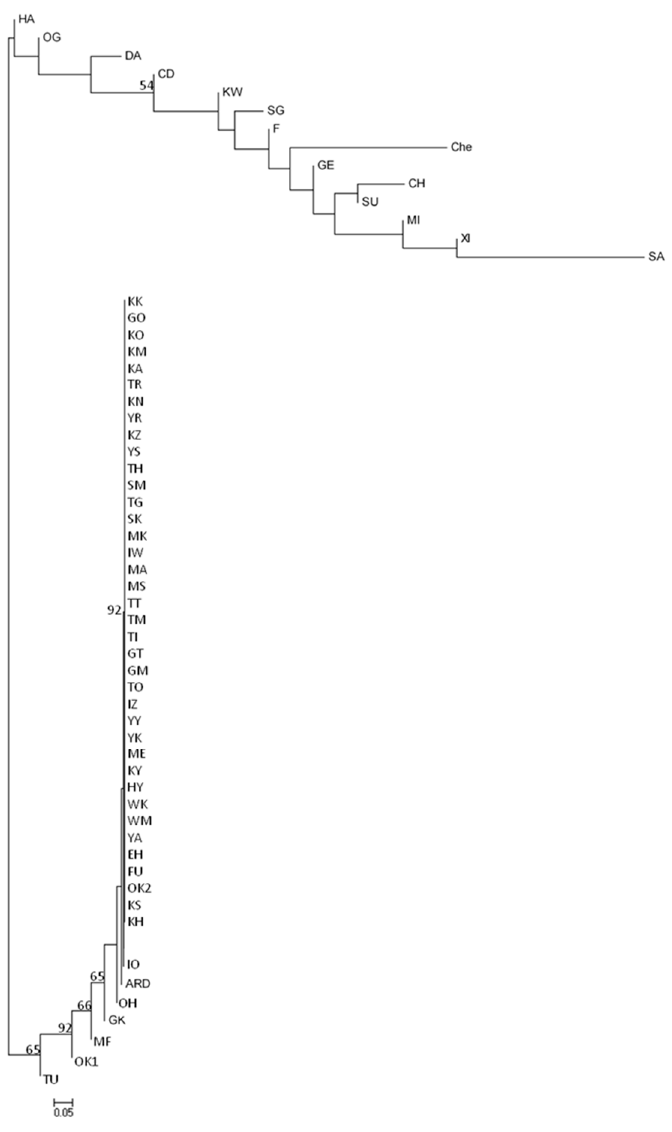
Figure A1. Neighbour-joining tree for Quercus acutissima Carruth. populations based on ( δμ ) 2 genetic distance. Numbers indicate mean probabilities based on 1000 bootstraps and only those greater than 50 are shown.